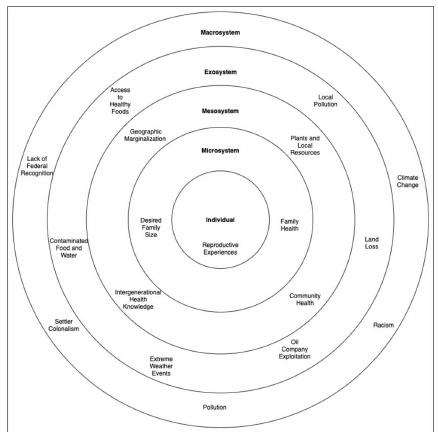
Figure 1. Environmental reproductive justice issues impacting tribal